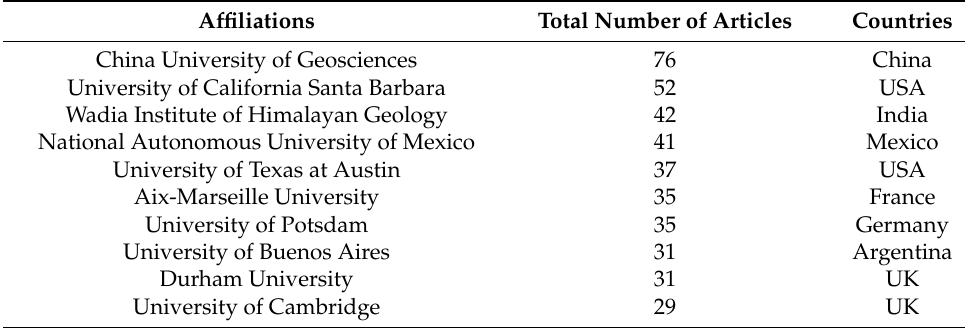
Table 2. Top 10 institutions on tectonic geomorphology in 1981–2021. Affiliations